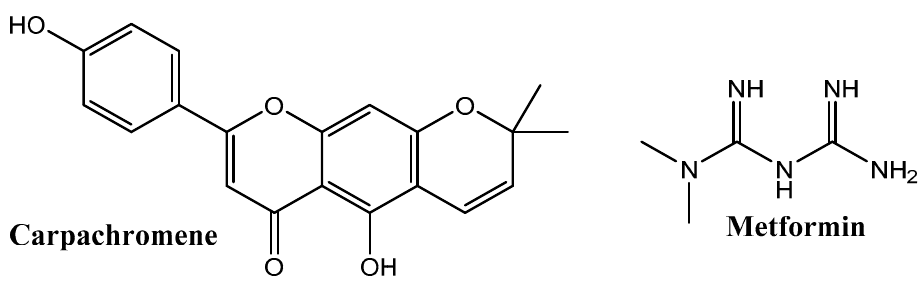
Figure 4. Carpachromene and Metformin.